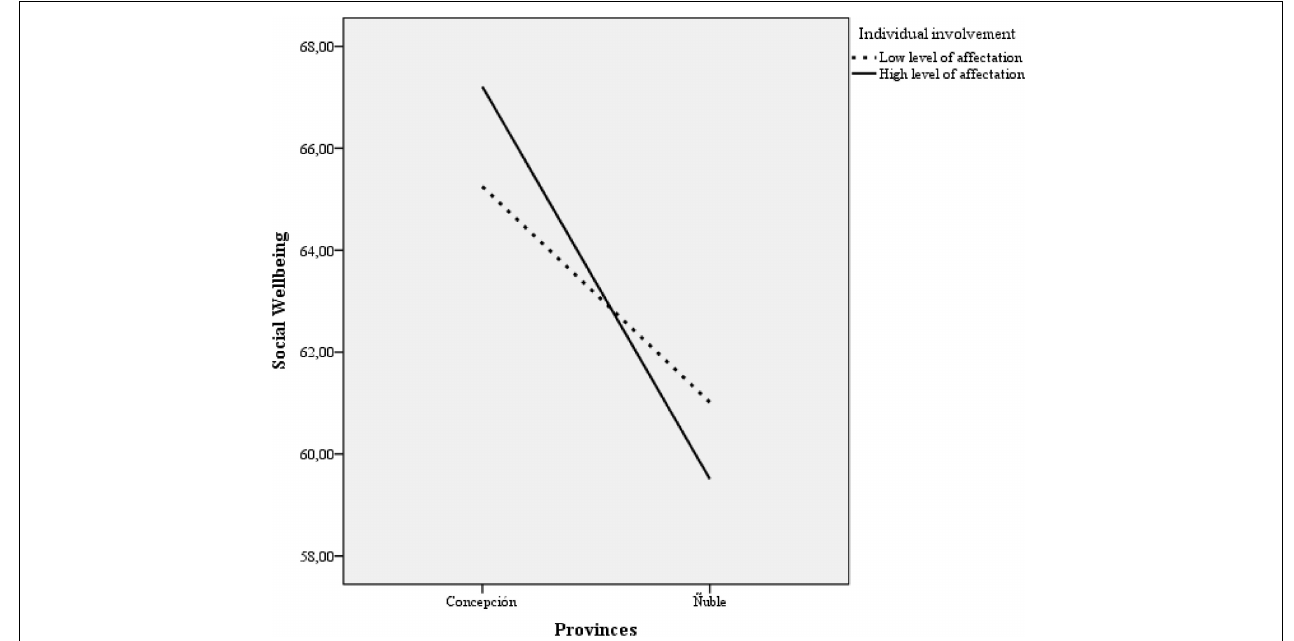
FIGURE 1 | SBW by low and high level of affectation and